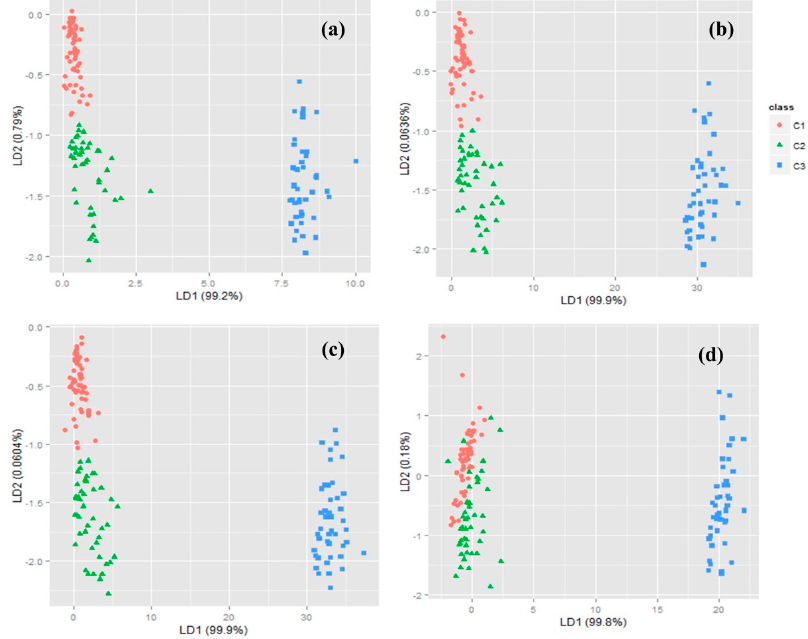
Figure 5. Score plots of LDA analyses based on 10 ( a ); 20 ( b ); 30 ( c ); and 49 ( d ) features. Sensors 2016 , 16 , 636 11 of 15